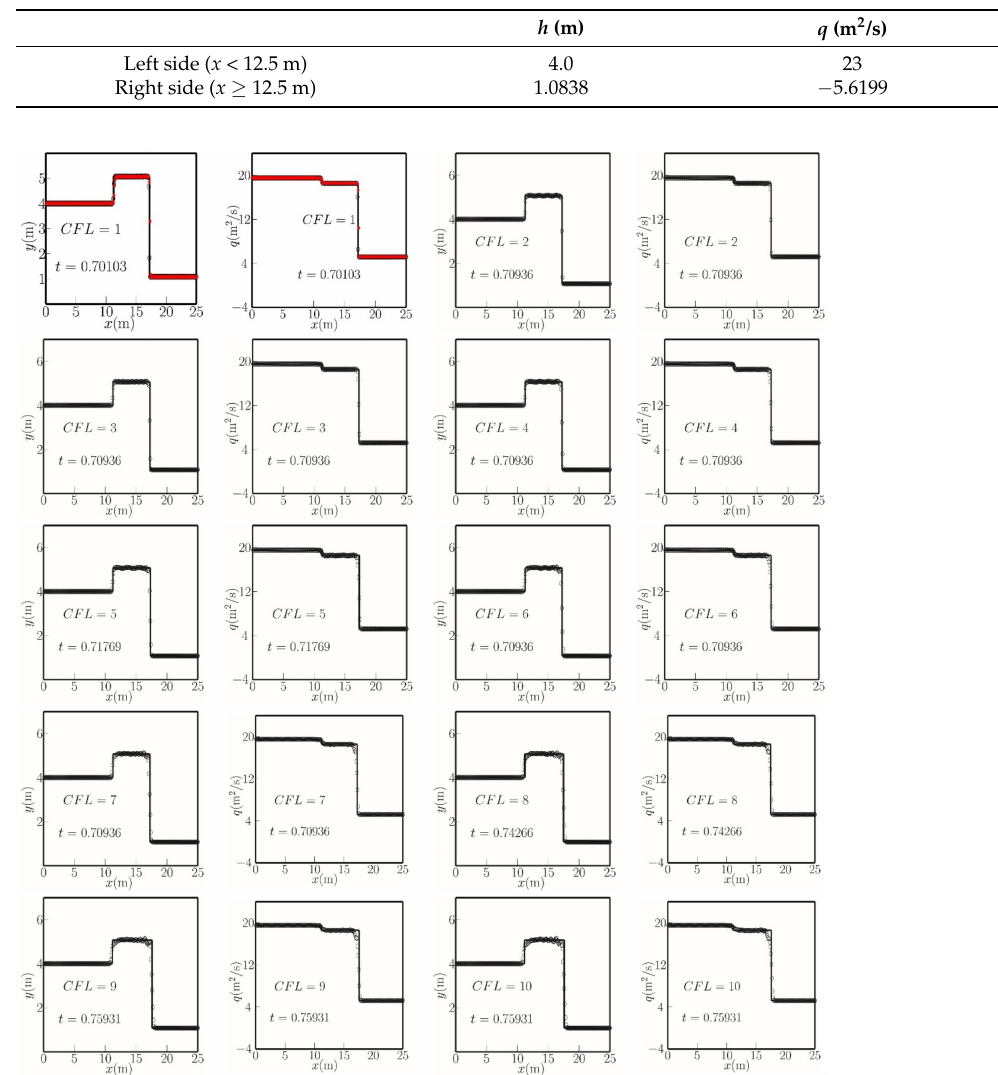
Figure 2. Free surface and mass flux profiles for two shockwaves in a frictionless, horizontal channel at a given time instant. Toro’s [2] almost exact solution (solid lines), Roe’s [3] scheme (red circles), and TVD-LTS predictions (open circles) for CFL = 1 to 10.